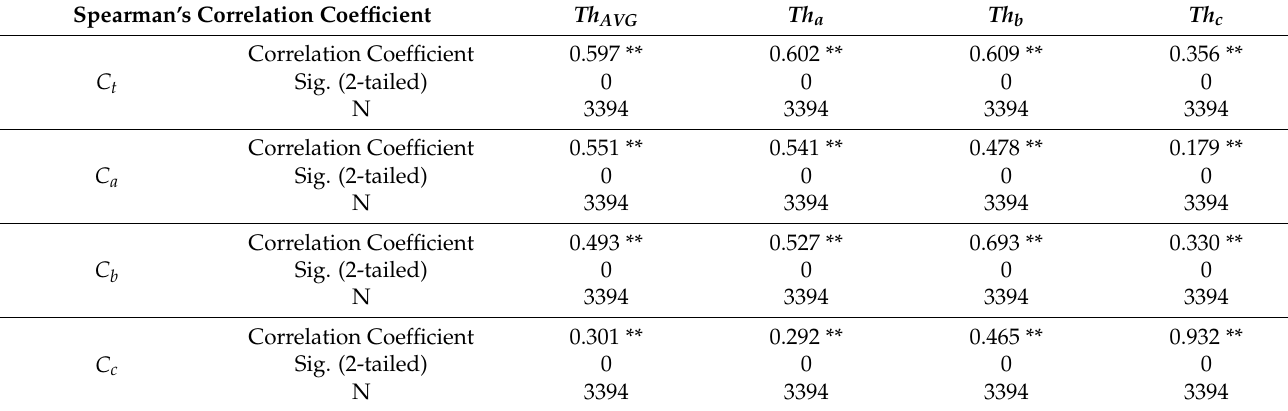
Table 6. The correlation coefficient between sea ice concentration and sea ice thickness.